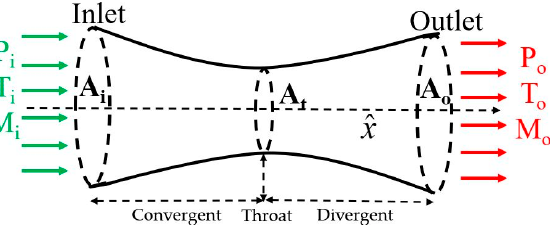
Figure 2. The gas flow and variables of de Laval (convergent-divergent) nozzle.